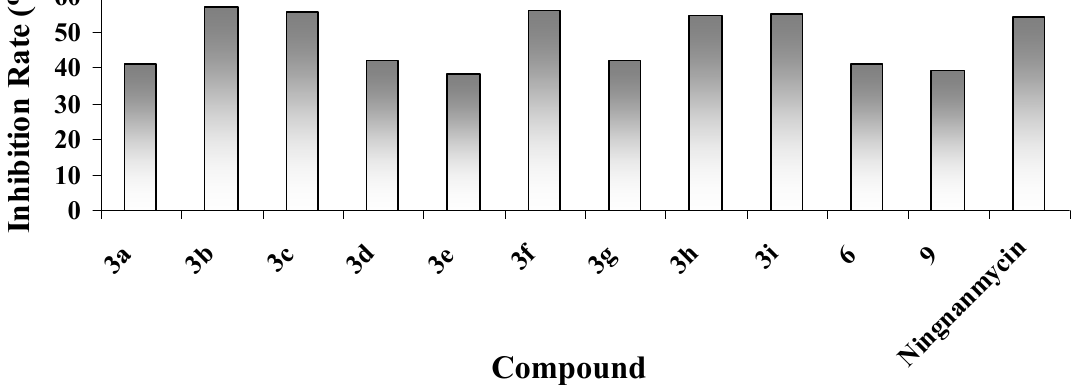
Figure 1. The anti-TMV activity of the synthesized